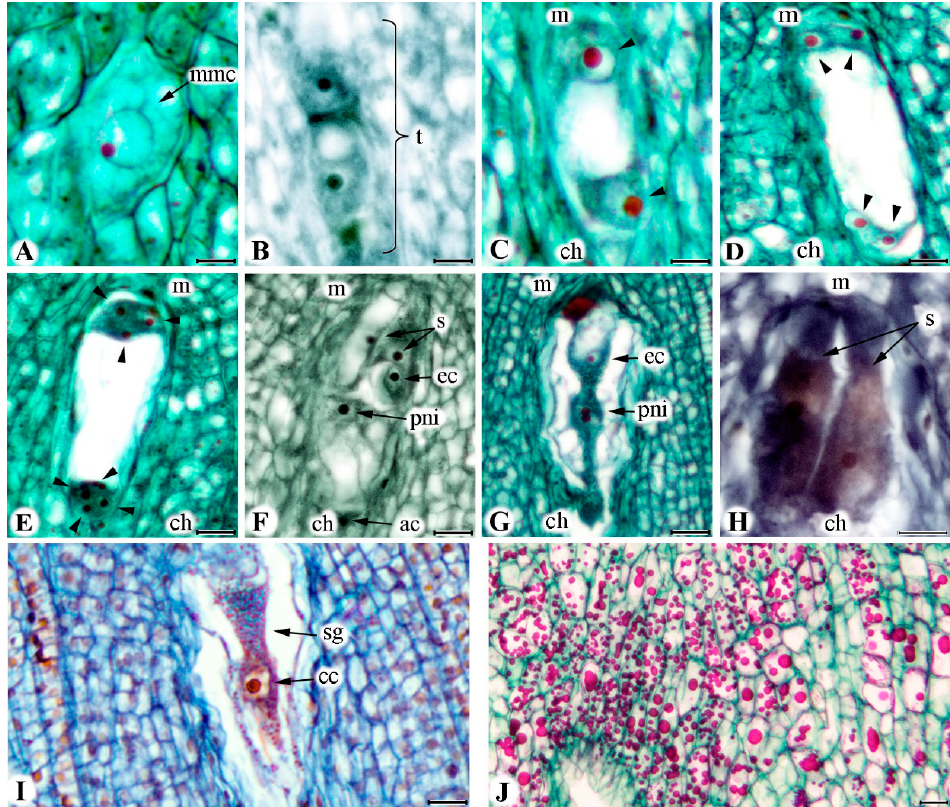
Figure 3. Development of embryo sac in pear cultivars ‘Ingeborg’ and ‘Celina’. ( A ) Megaspore mother cell—‘Ingeborg’. ( B ) Four megaspores in linear position—‘Celina’. ( C ) Two nuclei obtained after the first mitotic division of the functional megaspore—‘Ingeborg’. ( D ) Four-nuclei state after the second mitotic division—‘Ingeborg’. ( E ) Eight-nuclei state after third mitotic division—‘Ingeborg’. ( F ) Mature eight-nucleate embryo sac—‘Ingeborg’. ( G ) Normal position of egg cell and two polar